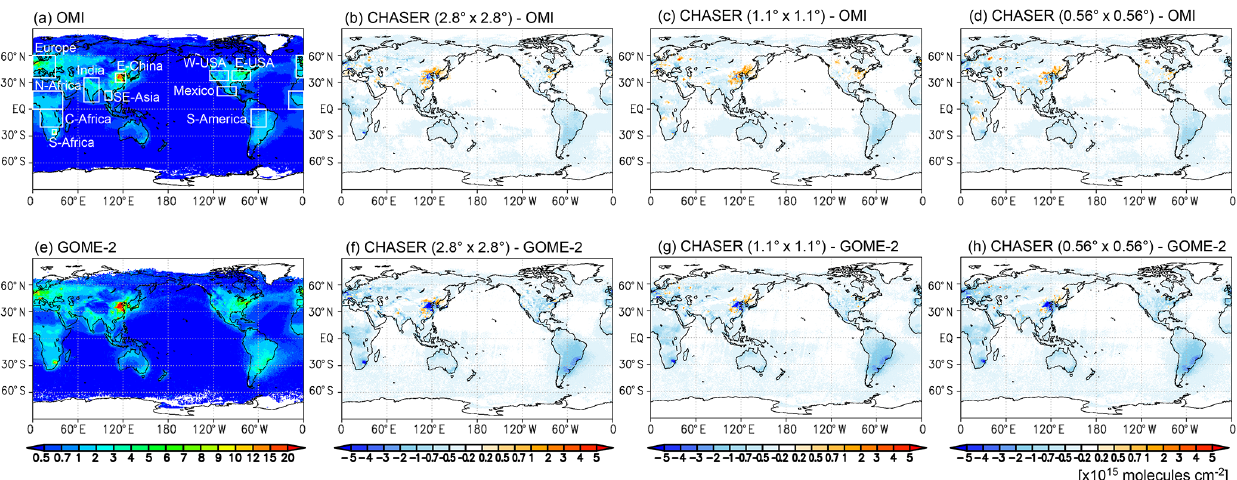
Figure 2. Annual mean tropospheric NO 2 column ( × 10 15 moleculescm − 2 ) from satellite retrievals (first column; a , e ) and differences between the model simulation at 2.8 ◦ (second column; b , f ), 1.1 ◦ (third column; c , g ), and 0.56 ◦ (fourth column; d , h ) resolutions and satellite retrievals from OMI (upper row; a–d ) and GOME-2 (lower row; e–h ) for 2008. The observed and simulated fields are mapped onto a 0.5 ◦ bin grid. The white square line in (a) represents the region used for the model evaluation.